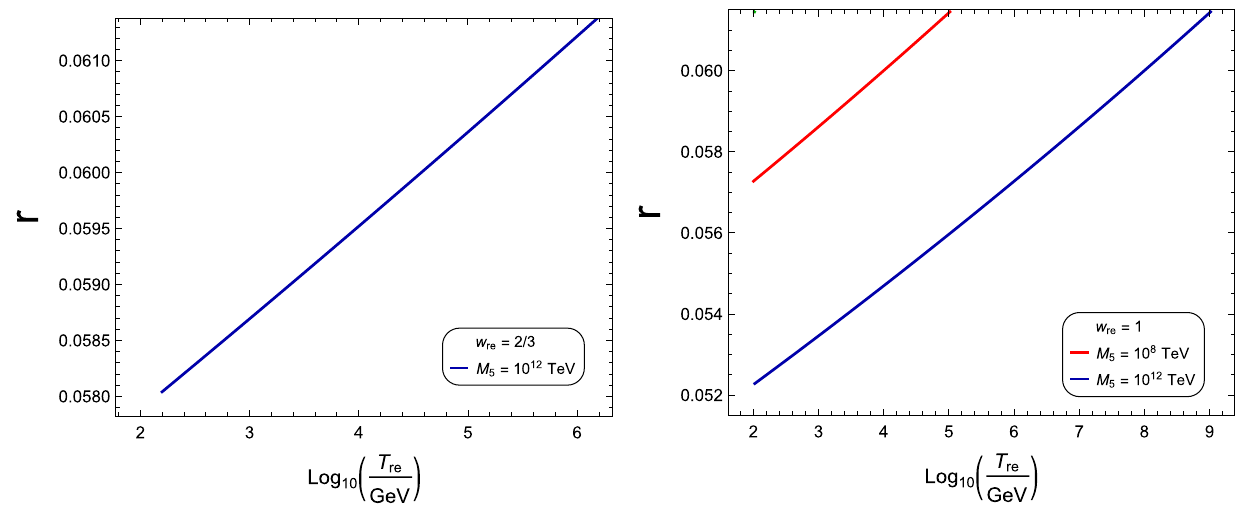
Fig. 11 Plots for the tensor-to-scalar ratio against the reheating temperature for Higgs-like inflation for w re = 2 / 3 , 1 and α = 0 . 0115. The red line corresponds to a mass of M 5 = 10 8 TeV and the blue line corresponds to a mass of M 5 = 10 12